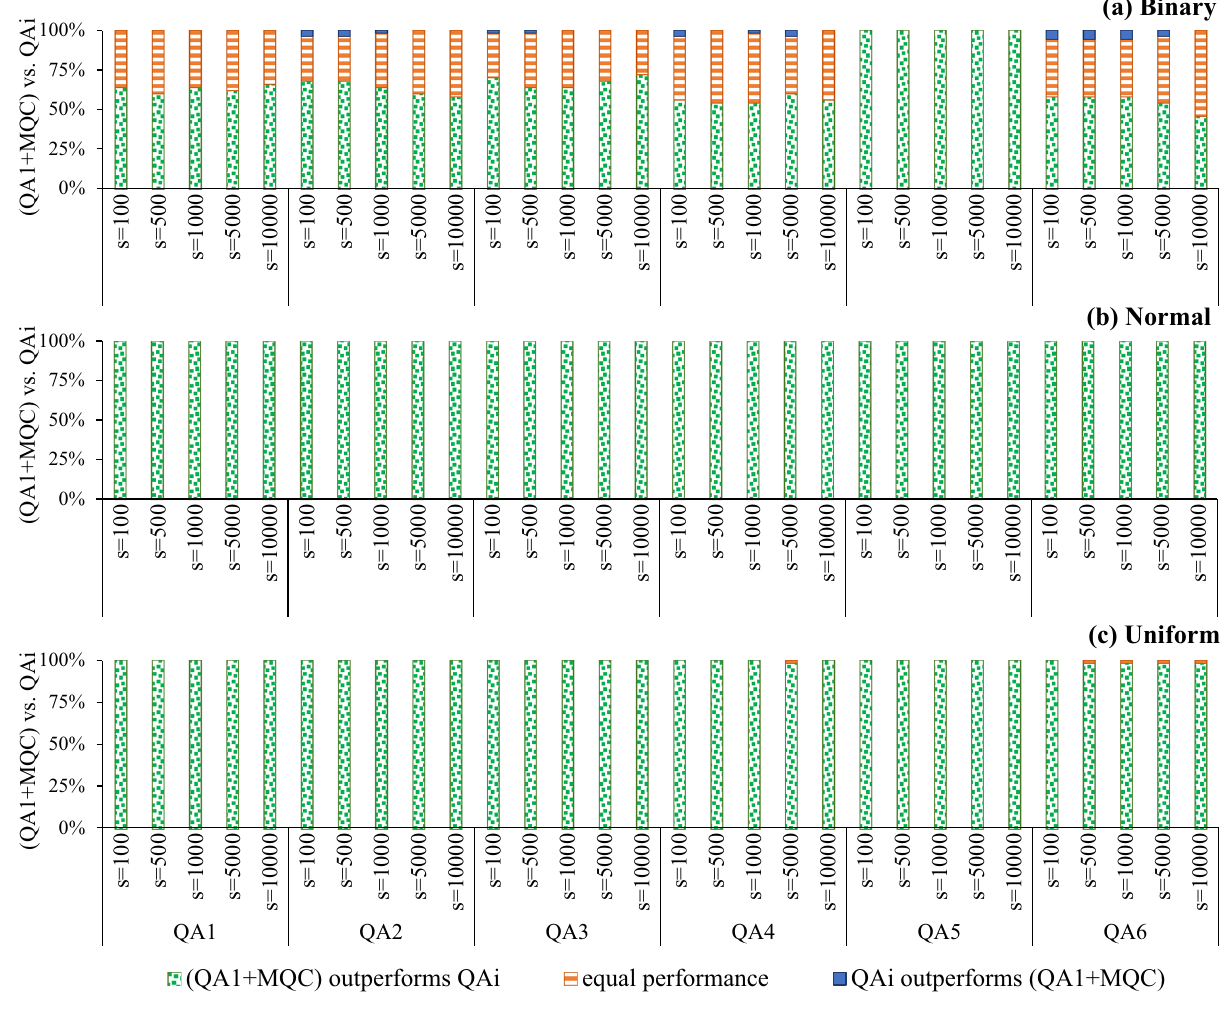
Figure 3. Comparing the performance of applying MQC to raw samples attained by a quantum annealer ( QA 1 + MQC ) with recent software/hardware advances—namely quantum annealing with five spin-reversal transforms ( QA 2 ) , quantum annealing with longer inter-sample delay ( QA 3 ) , quantum annealing with optimization postprocessing ( QA 4 ) , quantum annealing with sampling postprocessing ( QA 5 ) , and quantum annealing with five spin-reversal transforms, longer preparation time and optimization postprocessing ( QA 6 ) where s denotes the number of